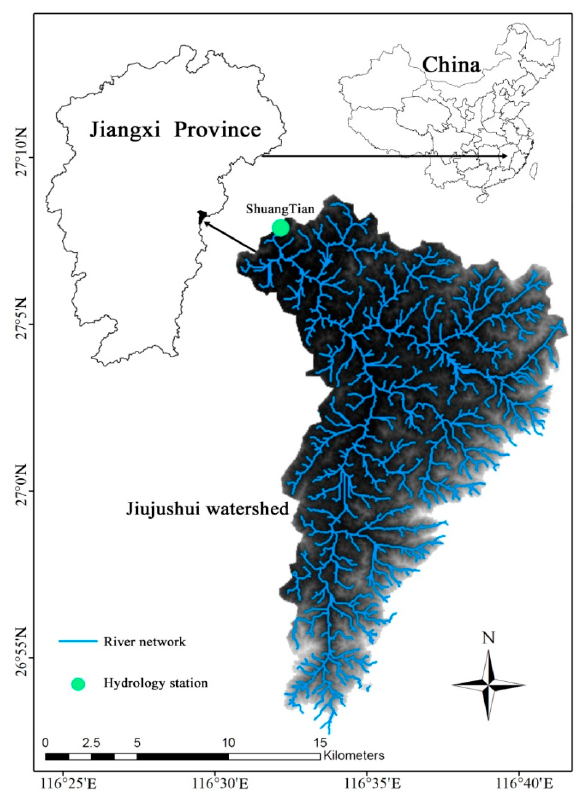
Figure 1. Location of the Jiujushui watershed.